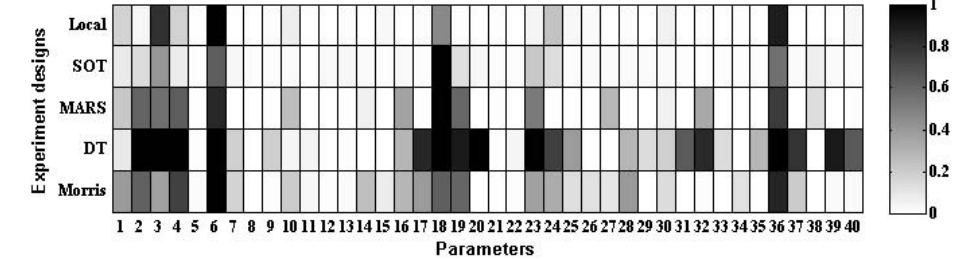
Fig. 7. The qualitative sensitivity analysis results of different methods for latent heat. The sensitivity scores are normalized to [0, 1]; 1 means most sensitive and 0 means least